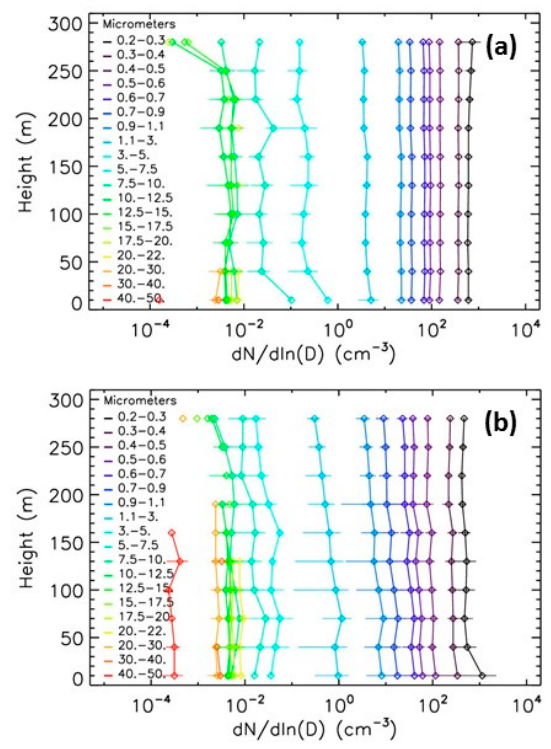
Figure 11. Evolution with height of LOAC number concentrations during the spring pollution events. (a) 14 March 2014; (b) 17 March 2015.